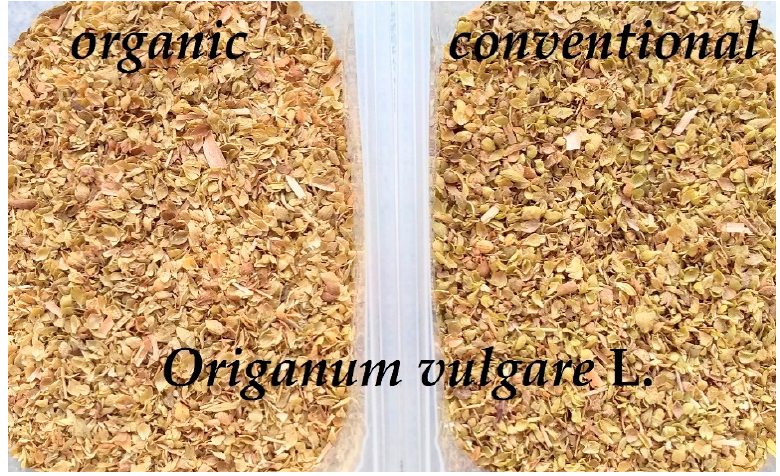
Figure 1. Comparison of colors of dry oregano from organic and conventional cultivation.